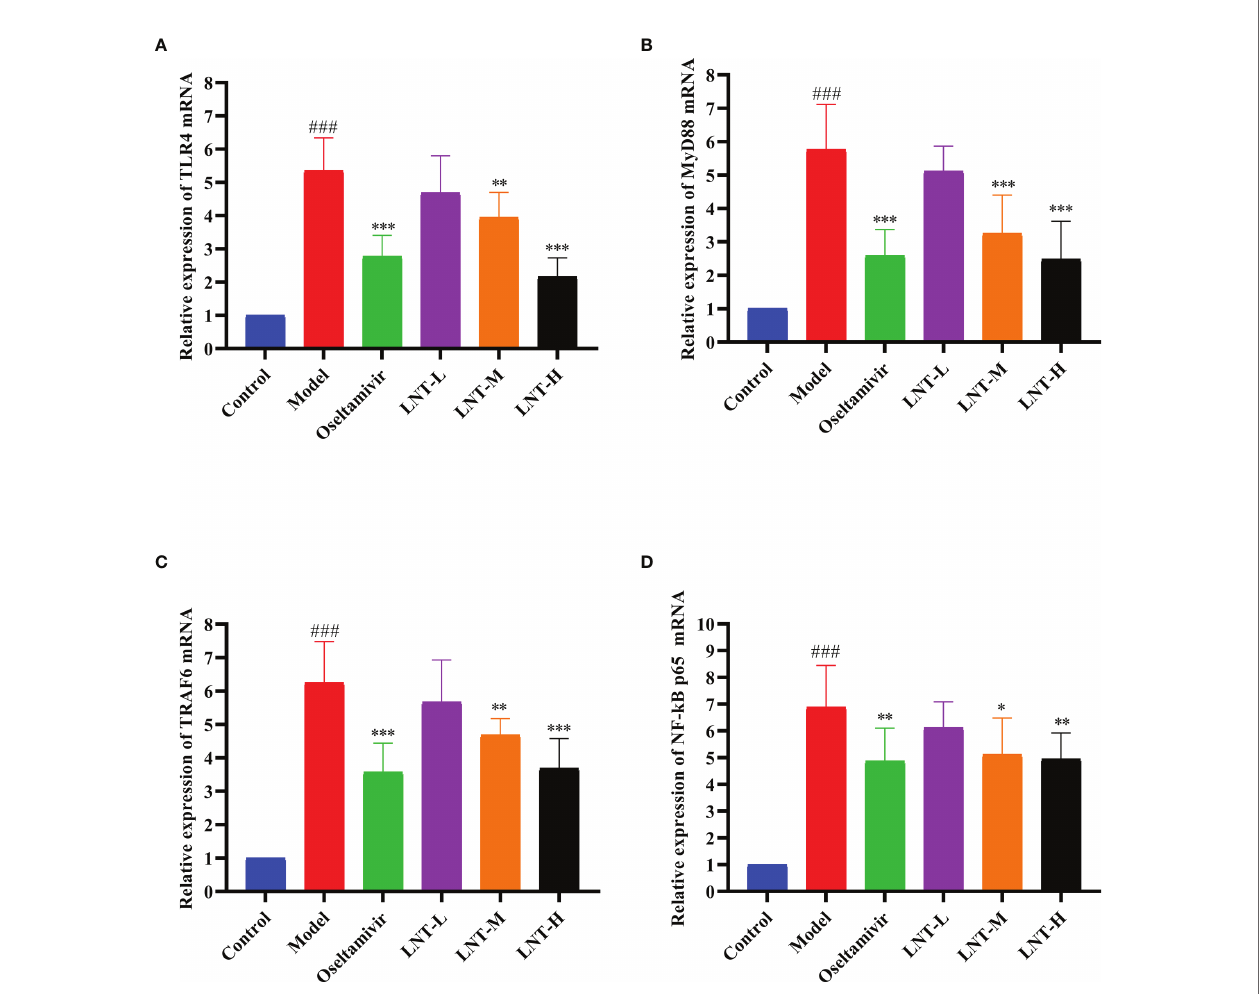
FIGURE 6 | Effect of LNT on the TLR4 signaling pathway in the mouse lung. The lungs of 5 dpi mice were collected, and the mRNA levels of TLR4 (A) , MyD88 (B) , TRAF6 (C) and NF- k B P65 (D) in the TLR4 signaling pathway were detected by RT – qPCR. LNT inhibited the expression levels of the four mRNAs. ### p < 0.001, vs control group (n=10); *p < 0.05, **p < 0.01, ***p < 0.001, vs. model group